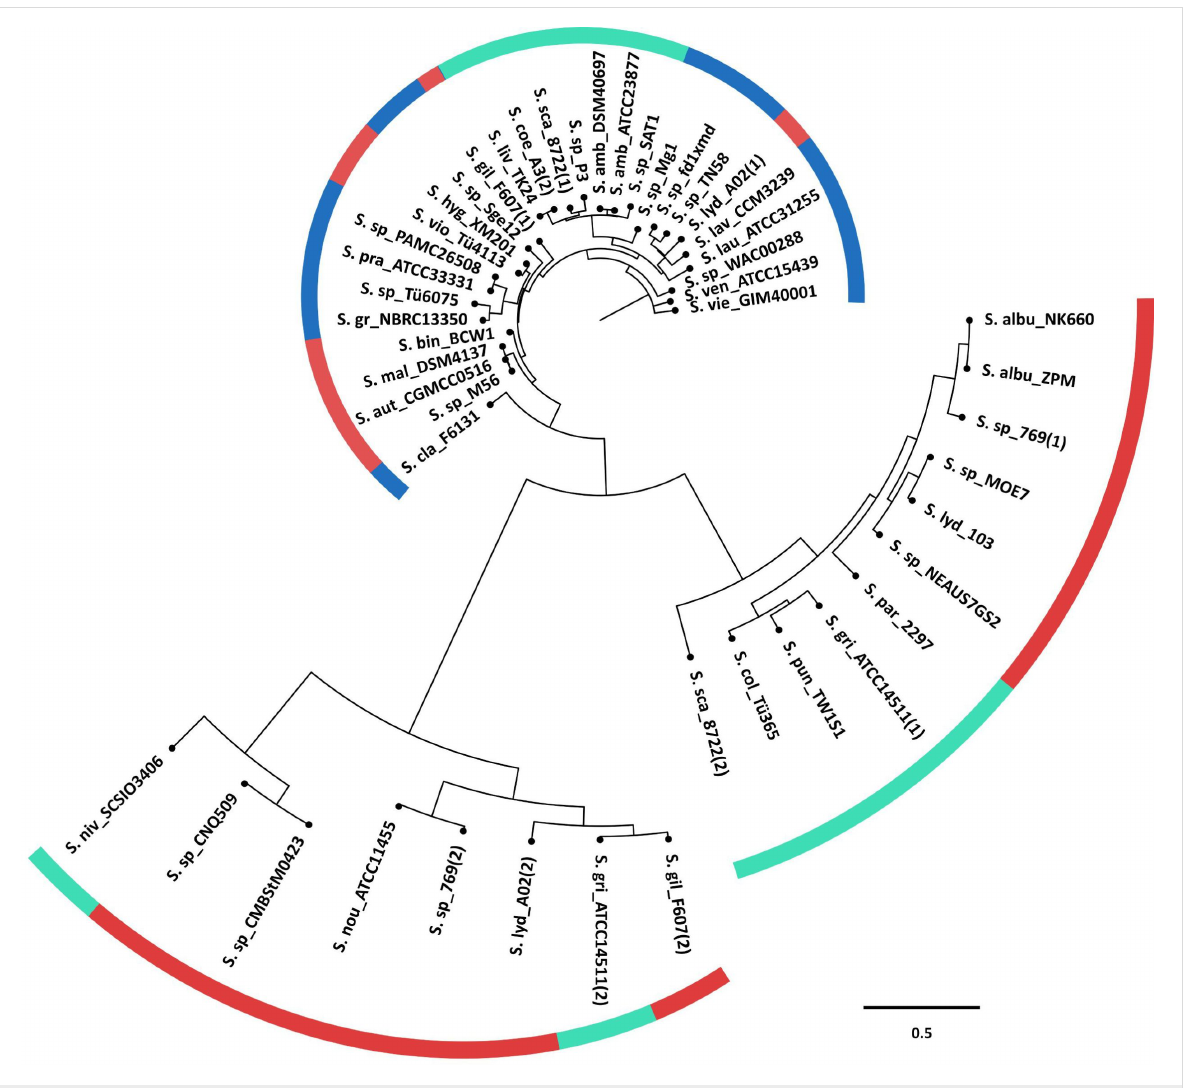
Figure 4: Phylogenetic tree of 2-MIB synthases. Unrooted maximum likelihood phylogenetic tree of 48 2-MIB synthases from the Streptomyces species in the phylogenetic tree in Figure 1. The colours of the outer curved lines correspond to the colours of the three main phylogenomic groups in the whole-genome species tree and indicate to which phylogenomic group each species belongs. The GenBank accession numbers of the 2-MIB synthases are listed in Table S4 (Supporting Information File 1).